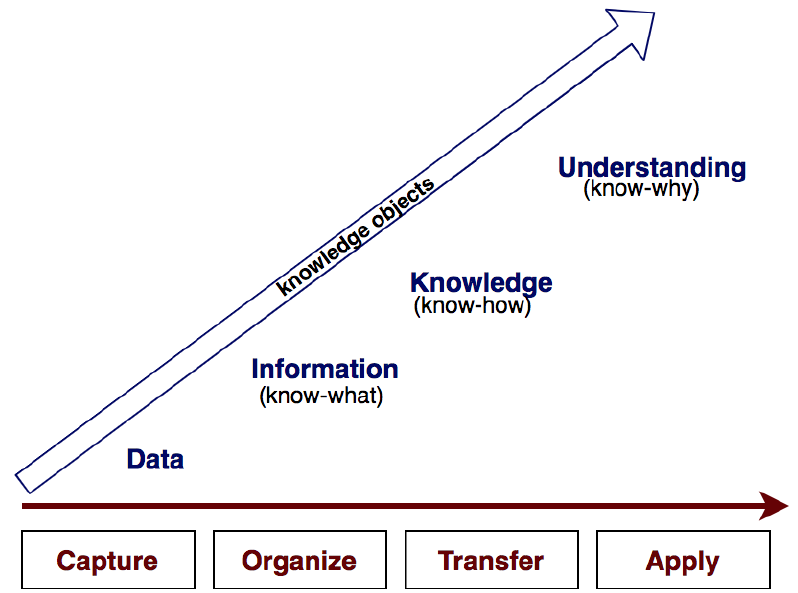
Figure 2. Knowledge development